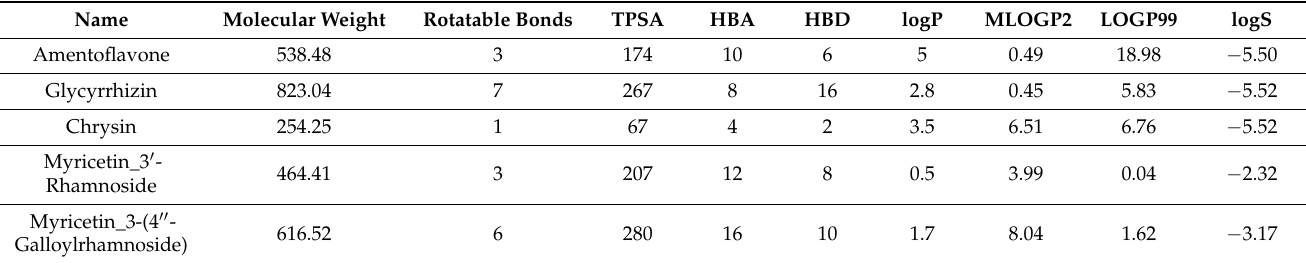
Table 2. Drug likeness properties of phytocompounds.